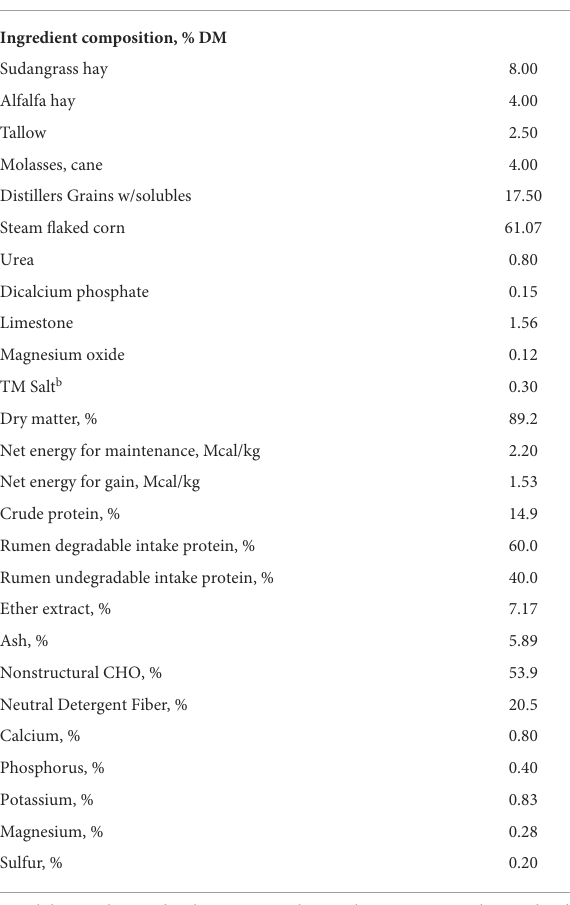
TABLE 1 Composition of experimental diets (DM